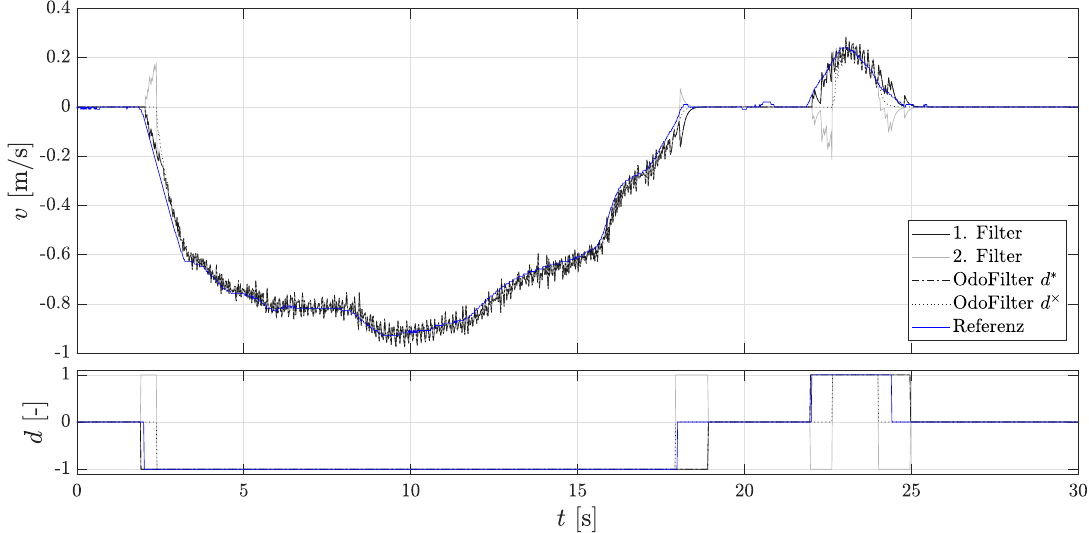
Figure 7. Velocities of the Dual-Localization filter during parking. ( Top ): The velocity of the 1st and the 2nd localization filter, the velocity of the localization filter using the fused estimated rolling direction of the new methods, the velocity of the localization filter using the rolling direction of the DWPC signal, and the reference velocity; ( Bottom ): Rolling